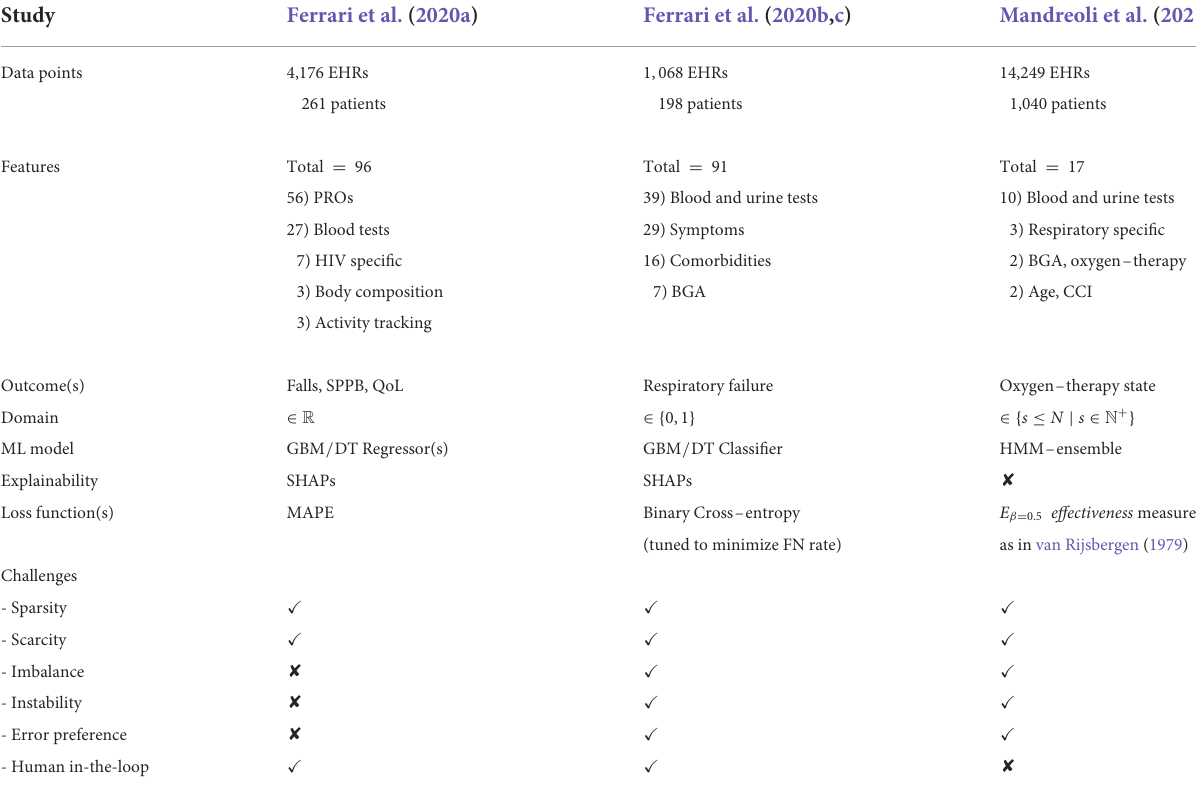
TABLE 1 Details about the ML applications, brought as